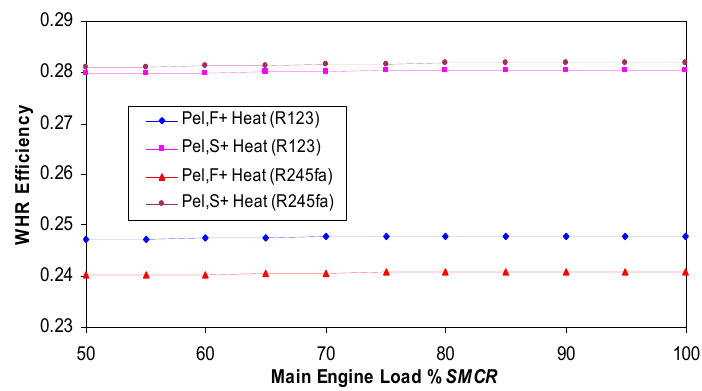
Figure 16. WHR Efficiency with organic fluids— η CHP,system (electrical power and heat).